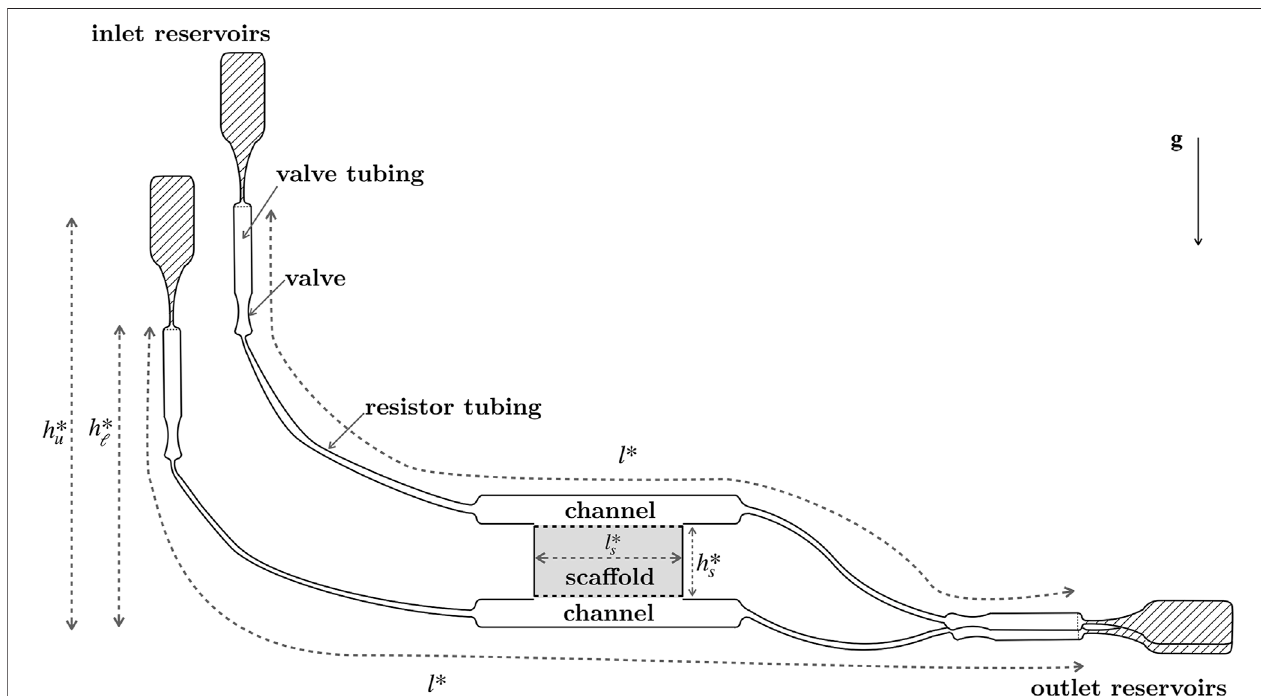
FIGURE 2 | Schematic of the valve-controlled, gravity driven platelet bioreactor designed by Shepherd et al. (2018), showing the inlet and outlet reservoirs, joined by valve tubing, valves, resistor tubing, channels, and a collagen scaffold. Megakaryocytes sit in the collagen scaffold and produce platelets, which are washed out into the loweroutlet reservoir. Theupper and lowertubing systemshave equal axial lengthscales, l *; theheightsofthe inlet reservoirs above the baseofthe bioreactor are h u * and h * ℓ , respectively; the scaffold height is h * s ; and the scaffold length is l * s .